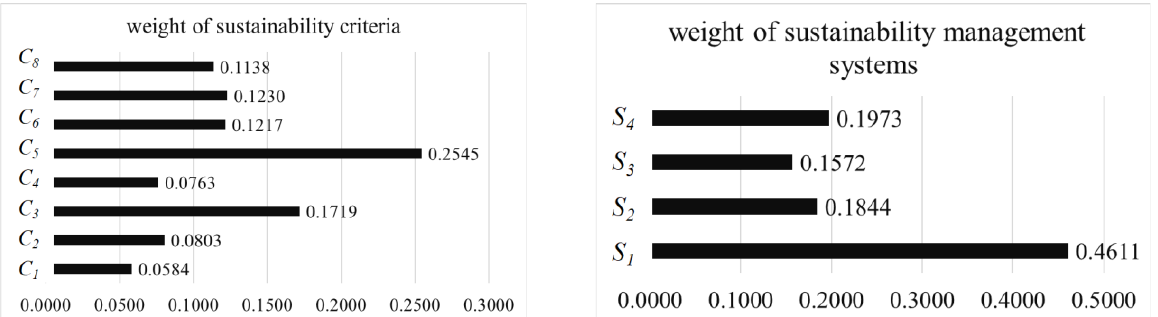
Figure 5. The weights obtained from the overall ratings of sustainability criteria for selecting an SMS.